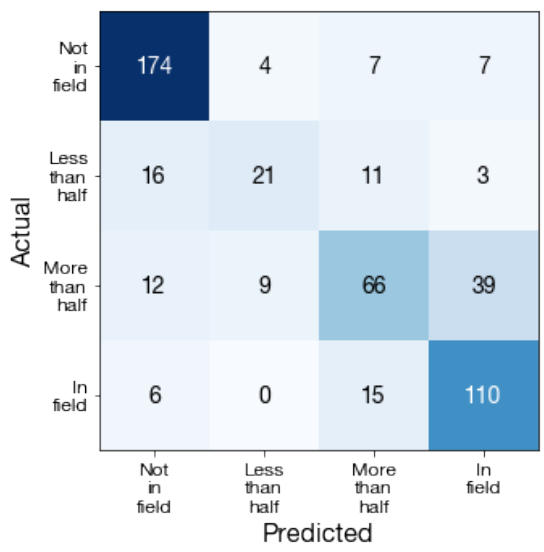
Figure A6. In-field classification confusion matrix. Values are shown for test set.